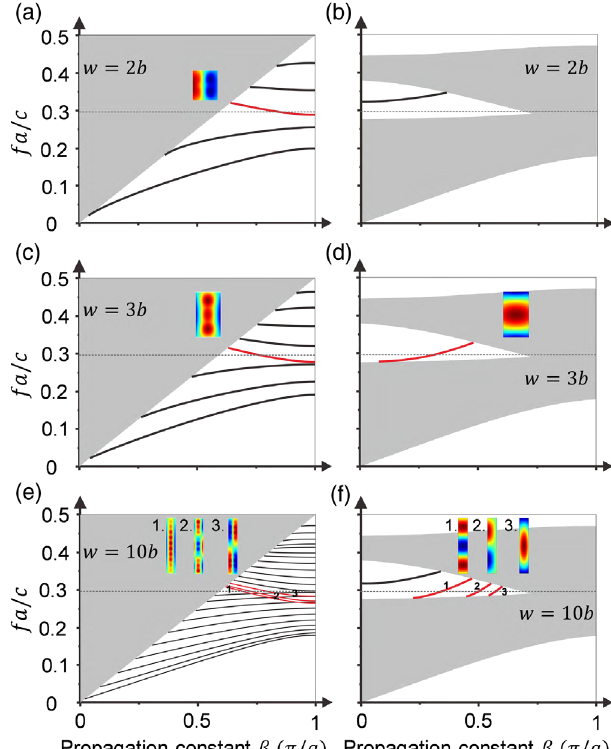
FIG. 9. Field distributions of the waveguide modes of the PC or free-space channels. (a) The waveguide mode of a PC channel with w ¼ 2 b . (b) The waveguide mode of an air channel with w ¼ 2 b . (c) The waveguide mode of a PC channel with w ¼ 3 b . (d) The waveguide mode of an air channel with w ¼ 3 b . (e) The waveguide mode of a PC channel with w ¼ 10 b . (f) The wave- guide mode of an air channel with w ¼ 10 b . The red line indicates their modes at working frequency fa=c ¼ 0 . 2962 (dashed line), and the illustrations show the electric field distribution of these propagation modes. The gray region shows the free-space (PC) band structure, and the black and red lines are the dispersion curves of the PC (free-space)